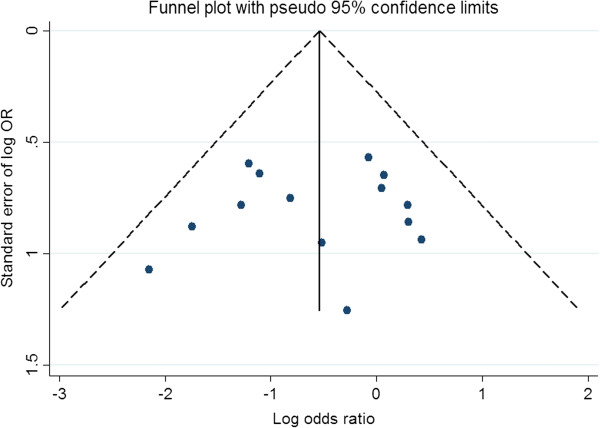
Funnel plot evaluating the effect of publication bias on studies for postoperative mortality.